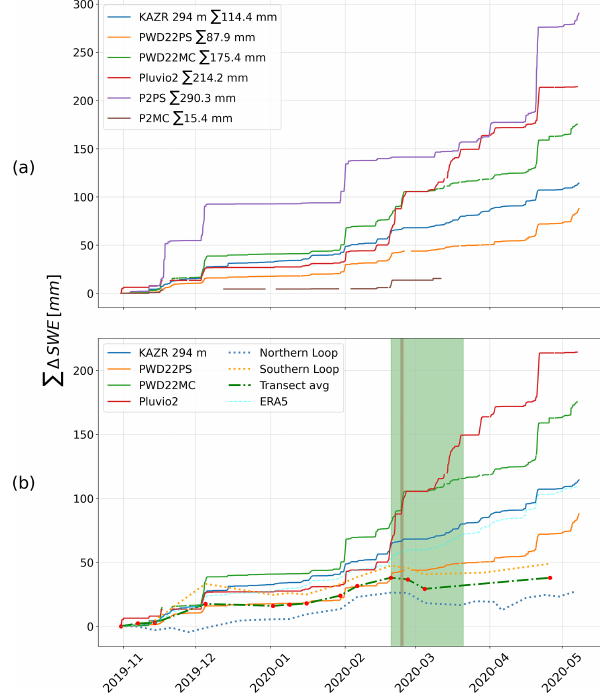
Figure 10. (a) Cumulative snowfall for different installed precipita- tion sensors during MOSAiC from 31 October 2019 to 7 May 2020. (b) Sensors, ERA5 estimates and SWE of the snow cover. The red dots show the days on which both transect loops were sampled. The red shading shows the time period of the strong drifting snow event on 24–25 February 2020. The green shaded area marks the strong drifting snow period where 45% of all cumulative horizontal mass flux was detected (Fig.